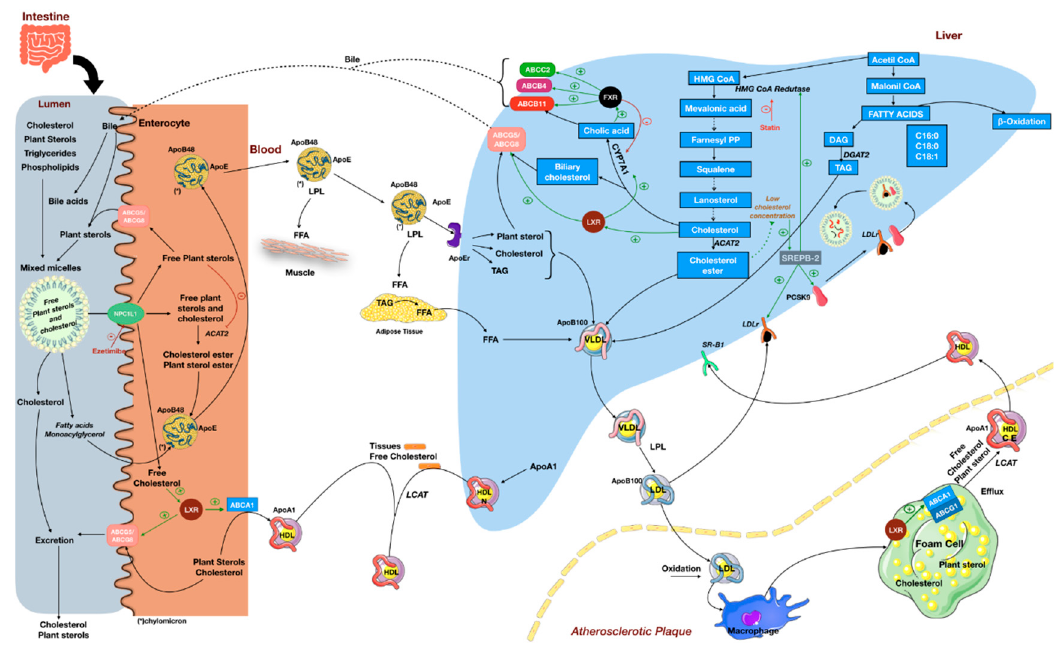
Figure 2. Plant sterol and cholesterol metabolism. Dietary lipids, biliary cholesterol, and bile acids are incorporated into mixed micelles in the intestinal lumen. Competition between plant sterols and free cholesterol during digestion causes a reduction in cholesterol solubilization and increases cholesterol excretion in feces. Free cholesterol and free plant sterols are absorbed through the NPC1L1 transporter, while other lipids are taken up into the enterocyte by facilitated diffusion at the brush border. Plant sterol absorption is controlled by ABCG5/8, which acts as an efflux pump to export free sterols from enterocytes back into the intestinal lumen. Alternatively, plant sterols may also be packed into lipoproteins in a similar way as cholesterol. After intestinal uptake, dietary and biliary free cholesterol (and some free plant sterols) are normally esterified by ACAT-2, incorporated into chylomicrons, and secreted into the lymph. Unesterified cholesterol is secreted back to the intestinal lumen by ABCG5/8. Chylomicrons reach the circulation and deliver free fatty acids to peripheral tissues through the activity of LPL. Chylomicron remnants undergo hepatic uptake, where they contribute to the formation of VLDL along with cholesterol esters (synthesized through the HMG CoA pathway) and TAG (synthesized through the malonyl-CoA pathway). Once plant sterols reach the liver, they can also be returned to the intestine by ABCG5/8 transporters at the hepatobiliary interface. VLDL particles are secreted into the bloodstream and give rise to LDL particles. LDL distributes cholesterol and plant sterols to tissues and undergoes hepatic uptake through LDL receptors (LDLr). However, LDL particles may infiltrate the endothelial intima where they undergo oxidative and enzymatic modification. Uptake of modified LDL by intima macrophages leads to the formation of foam cells and fatty streaks. The atherosclerotic process may be attenuated by HDL, as it promotes cholesterol efflux from other tissues by LCAT, and also from the macrophages. HDL is recognized by SRB1 receptors in the liver and deliver cholesterol (or plant sterols) for biliary excretion, keeping the “cholesterol reverse transport” cycle. Hepatic cholesterol homeostasis is controlled by several sensors. Decreased levels of cholesterol esters activate SREBP-2, which upregulates HMG CoA reductase, increases LDL receptor (LDLr) expression, and induces expression of PCSK9, that after secretion binds to LDLr on the hepatocyte surface, forming a complex PCSK9–LDLr, which is internalized and undergoes degradation. On the other hand, increased levels of cholesterol in hepatocytes leads to activation of LXR and FXR, which upregulate expression of enzymes and transporters involved with biliary excretion. Activation of LXR in enterocytes leads to luminal excretion of cholesterol and facilitates intestinal HDL synthesis. For details on lipid metabolism see Ref. [41–43]. Abbreviations: ABCA1, ATP-binding cassette, subfamily A, member 1; ABCG1, ATP- binding cassette, subfamily G, member 1; ABCG5, ATP-binding cassette, subfamily G, member 5; ABCG8, ATP-binding cassette, subfamily G, member 8; ACAT2, acetyl-CoA acetyltransferase 2; CE, cholesterol ester; CM, chylomicron; DAG, diacylglycerol; DGAT2, diacylglycerol O-acyltransferase 2;